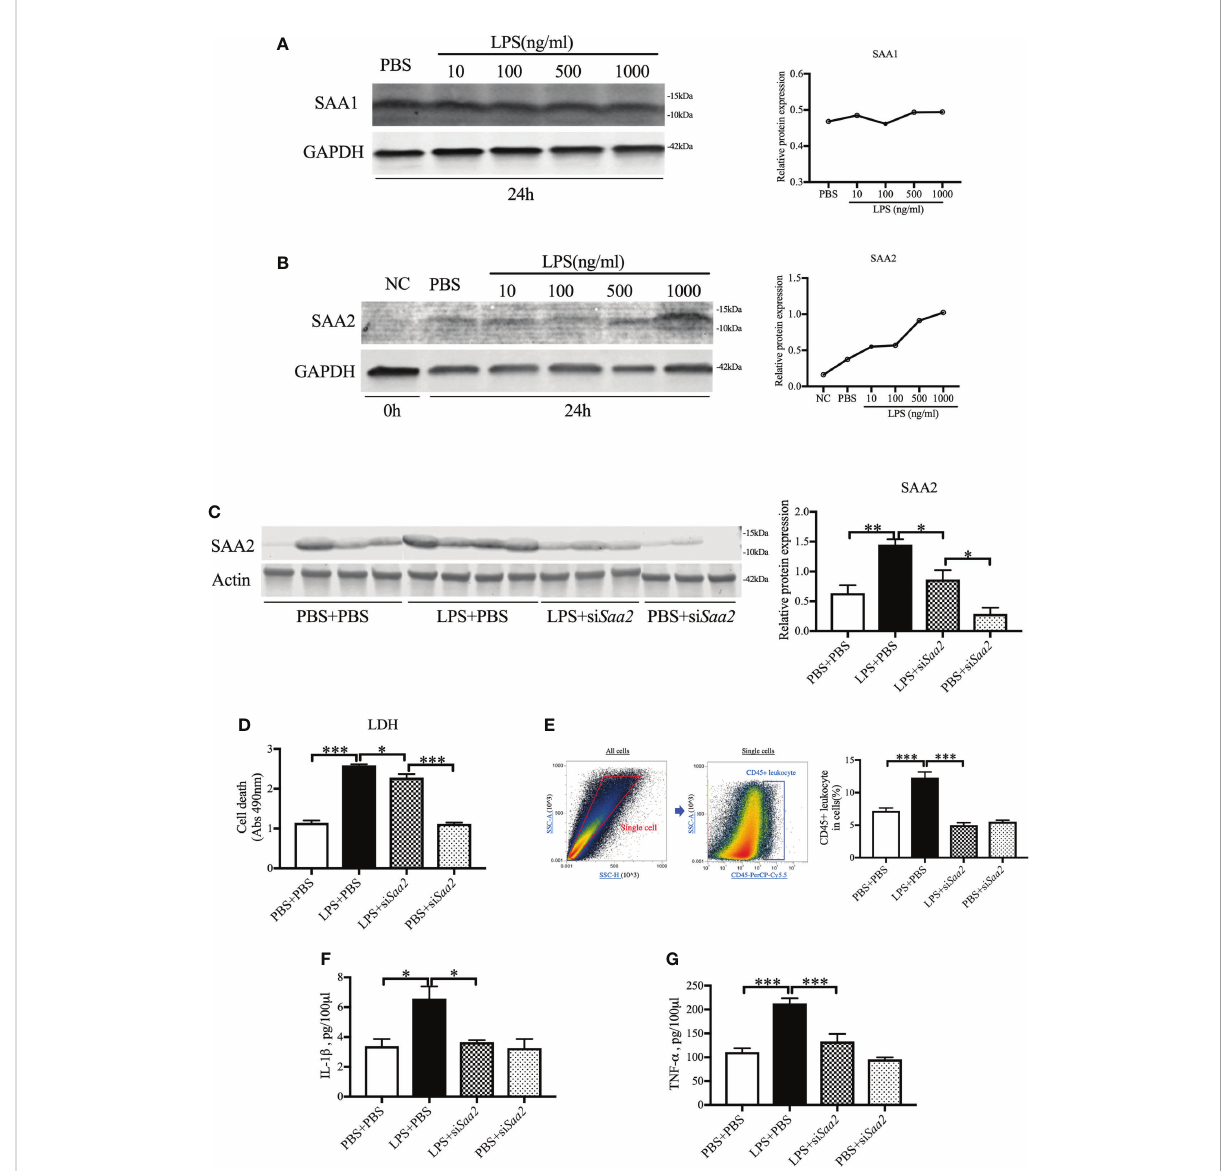
FIGURE 4 siRNA against Saa2 reduces SAA2 and decreases in fl ammation in explant culture of placental tissue following LPS exposure. On E17, placenta slices were stimulated with control media and lipopolysaccharide (LPS 100, 500, 1,000 ng/ml) with or without siRNA against serum amyloid A 2 (si Saa2 ) for 24 (h) Gel images of SAA1 (A) and SAA2 (B) expression and statistical analysis normalized to the levels of GAPDH as a loading control. (C) Gel images of SAA2 expression in placental explant slices and statistical analysis normalized to the levels of actin as a loading control using Western blot. LPS: 500 ng/ml. (D) Cell cytotoxicity was determined by lactate dehydrogenase (LDH) assay. (E) Flow cytometry was performed to measure CD45+ leukocytes in the placenta slices. Debris and doublets were excluded by gating on side scatter height SSC-H versus SSC-A to delaminate singlets. Placental leukocytes were gated sequentially on CD45 + versus SSC-A properties. The ratio of CD45+ leukocytes in the placenta slices was statically compared between groups. The concentrations of IL-1 b (F) and TNF- a (G) in the culture media were measured by enzyme-linked immunosorbent assay (ELISA). PBS+PBS, n = 4; LPS+PBS, n = 4; LPS+si Saa2 , n = 3; PBS+si Saa2 , n = 3. Values are expressed as mean ± SEM, * p < 0.05, ** p < 0.01, *** p < 0.001. One-way